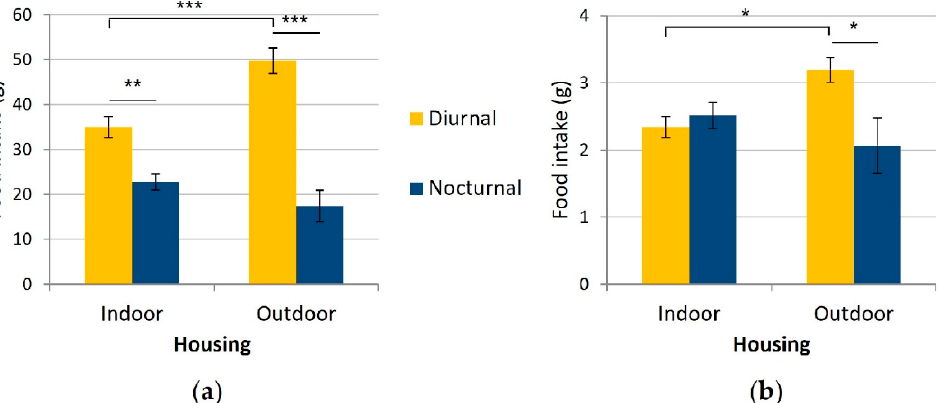
Figure 10. Mean daily ( a ) and hourly ( b ) nocturnal and diurnal food intake (g) of the cats according to their housing condition (indoors (n = 15) versus outdoors (n = 8)). Error bars represent standard errors, (*) indicates p < 0.05, (**) indicates p < 0.01, (***) indicates p < 0.001.